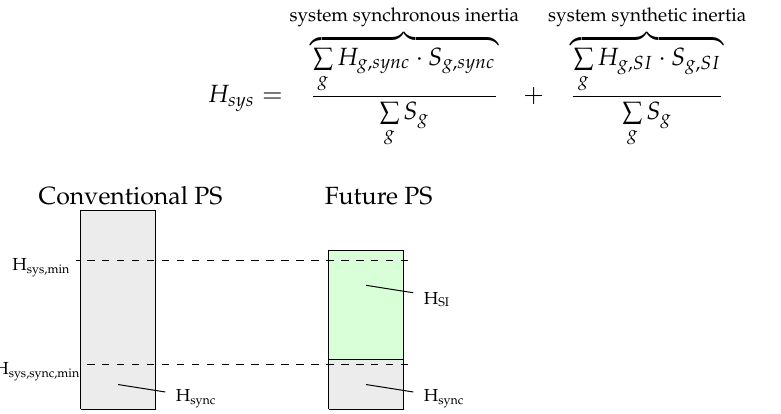
Figure 1. Schematic illustration of inertia in present power system and the system inertia composition in future power